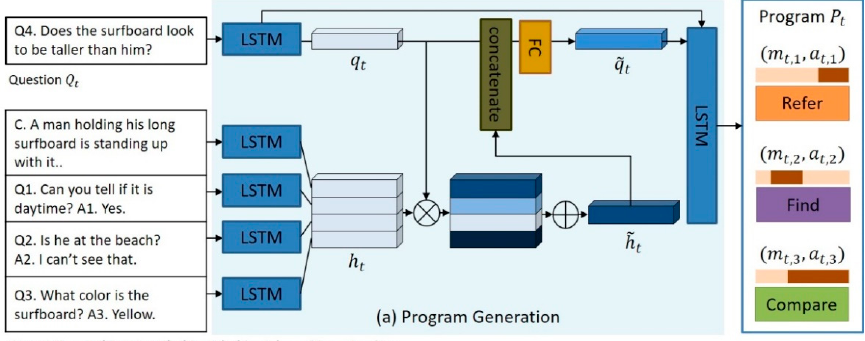
Figure 3. Program generation.